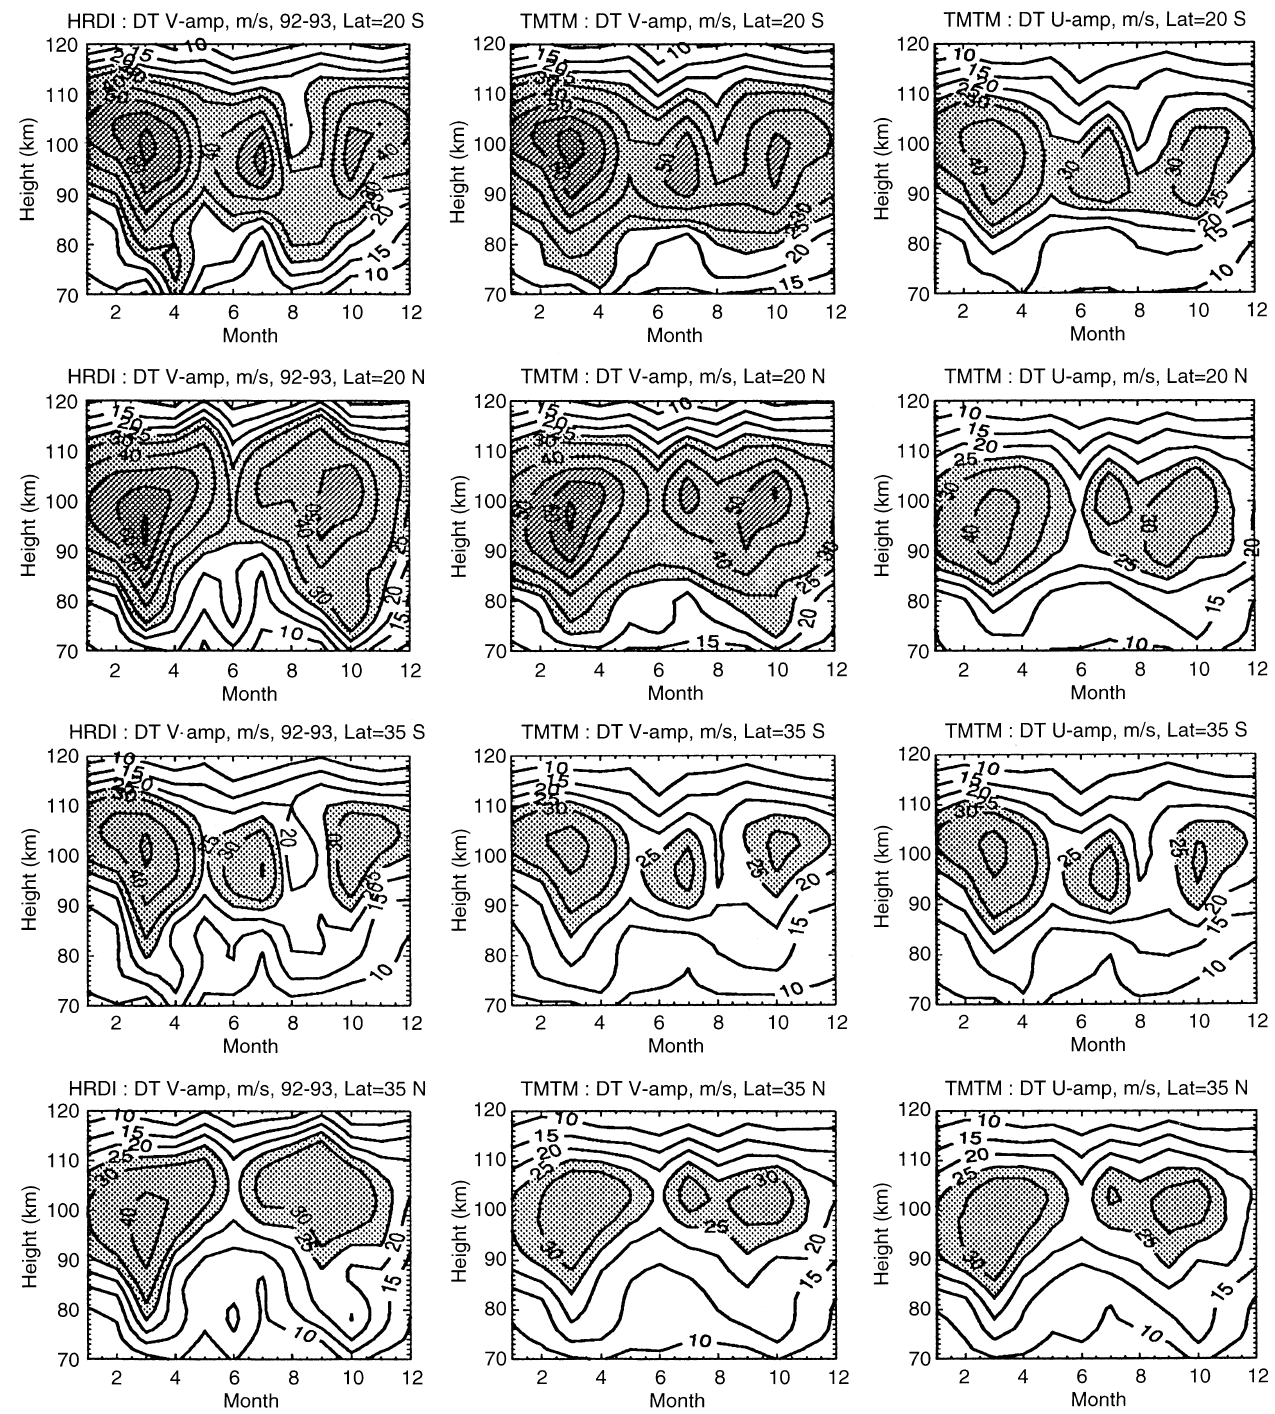
Fig. 8. Seasonal changes in the zonal and diurnal wind amplitudes as predicted by the TMTM at di(cid:128)erent latitudes as a function of altitude and month of year. First two rows are for 20 S and 20 N; last two